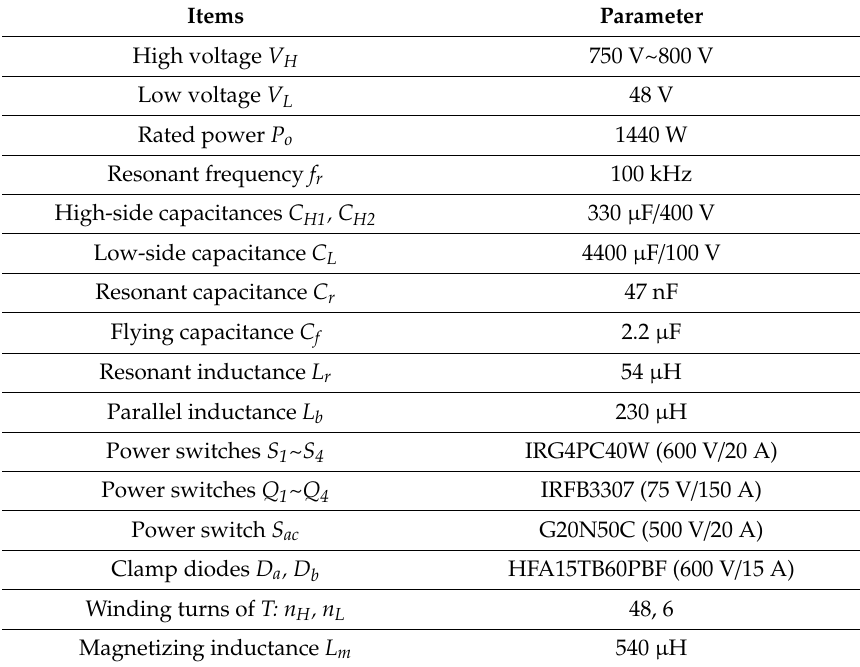
Table 1. Parameters and specifications of the presented